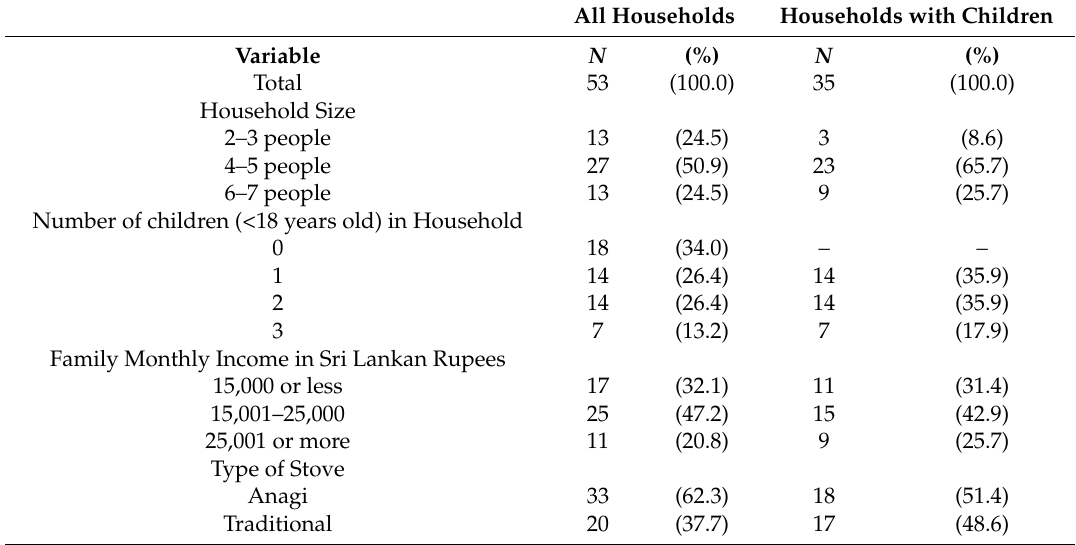
Table 1. Distribution of demographic and household exposure indicators among Sri Lankan households. All Households Households with